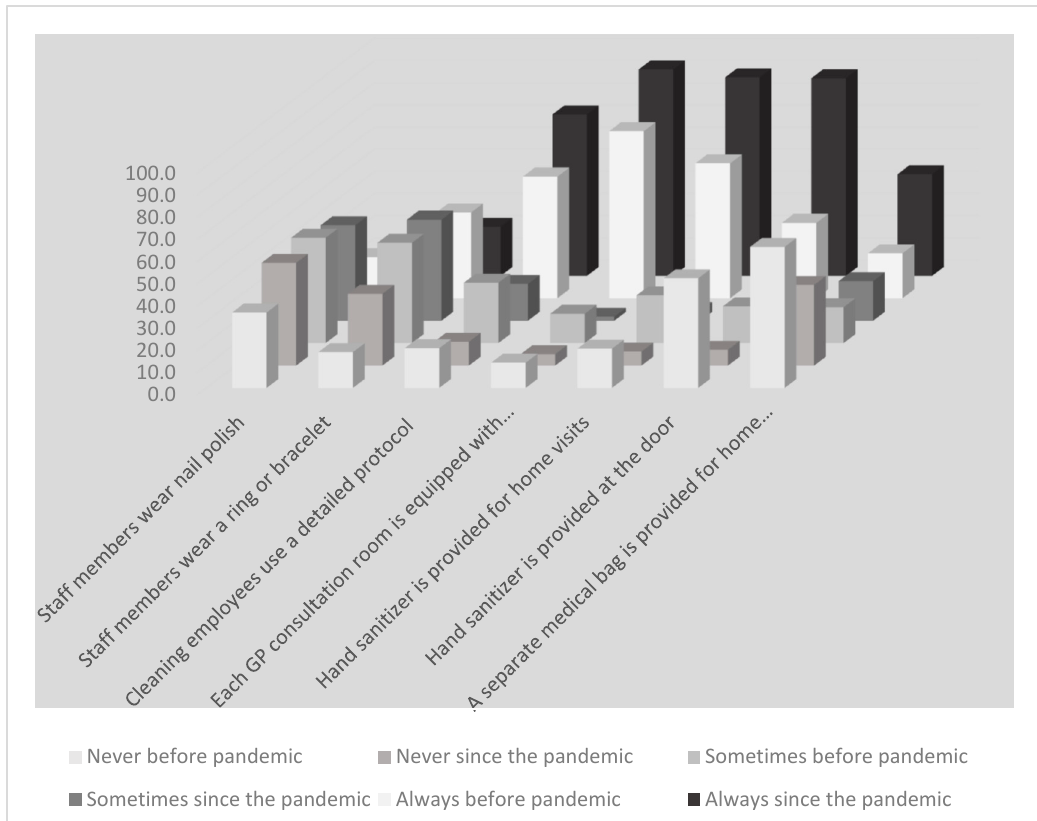
Figure 2. IPC measures before and since COVID-19.